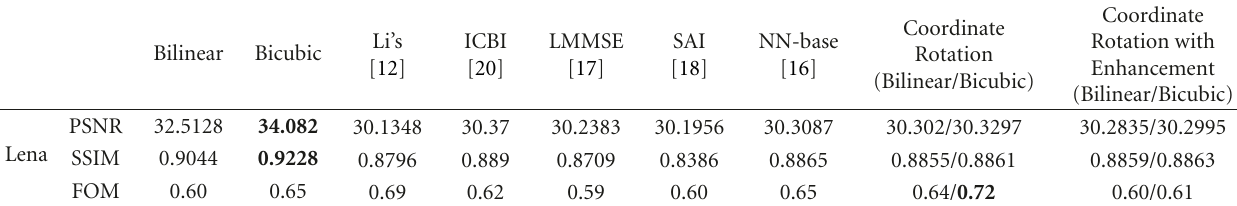
Table 4: Comparative results in PSNR, SSIM, and FOM of di ff erent algorithms applied to “Lena” downsampled by averaging for interpolation. The best results are denoted in